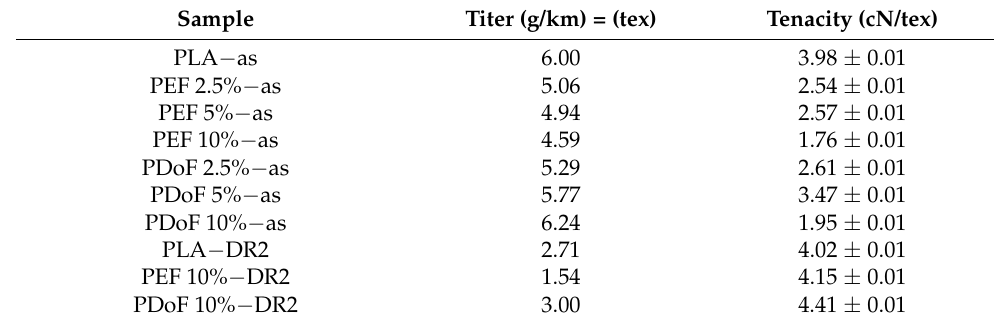
Table 6. Titer and tenacity values of the fibers blends (as − spun and drawn at DR = 2).